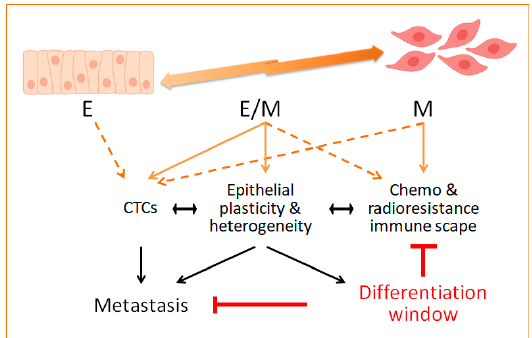
Figure 1. Tumours are formed by heterogeneous and phenotypically diverse cancer cell populations. During tumour progression, epithelial cells lose their apical–basal polarity and acquire mesenchymal traits through the Epithelial-to-mesenchymal transition (EMT) program. In vivo, EMT generates a wide spectrum of cellular phenotypes from epithelial (E) to mesenchymal (M) phenotypes, accompanied by gain of migratory and invasive abilities. Cells in hybrid E/M states give raise to heterogeneous populations, some endowed with stem cell-like features. These metastable E/M cells, able to rapidly adapt to changes in the tumour microenvironment, could ultimately be responsible for tumour resistance to anti-cancer therapy and immune scape. Indeed, hybrid E / M cells are associated with tumour progression, metastatic dissemination and tumour recurrence since they thrive in hostile situations due to their inherent plasticity. Circulating tumour cells (CTCs) isolated from patients display E / M traits and, in some tumour types, are considered crucial for metastatic colonization. Since treatment resistance and metastasis are the main consequences of cancer progression, drugs aimed at exploiting epithelial plasticity by promoting a cell irreversible di ff erentiation state might constitute a successful anti-cancer strategy.